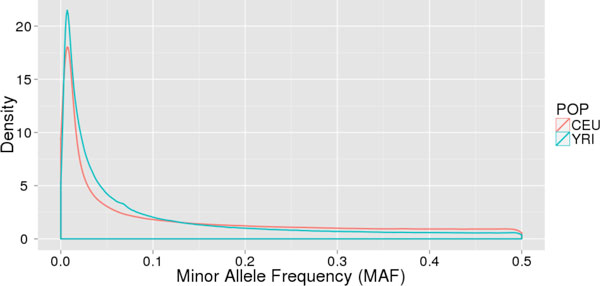
Minor allele frequency distribution for CEU and YRI. Minor allele frequency distribution for CEU (red) and YRI (blue) populations. The African population has a higher density of low frequency variants.